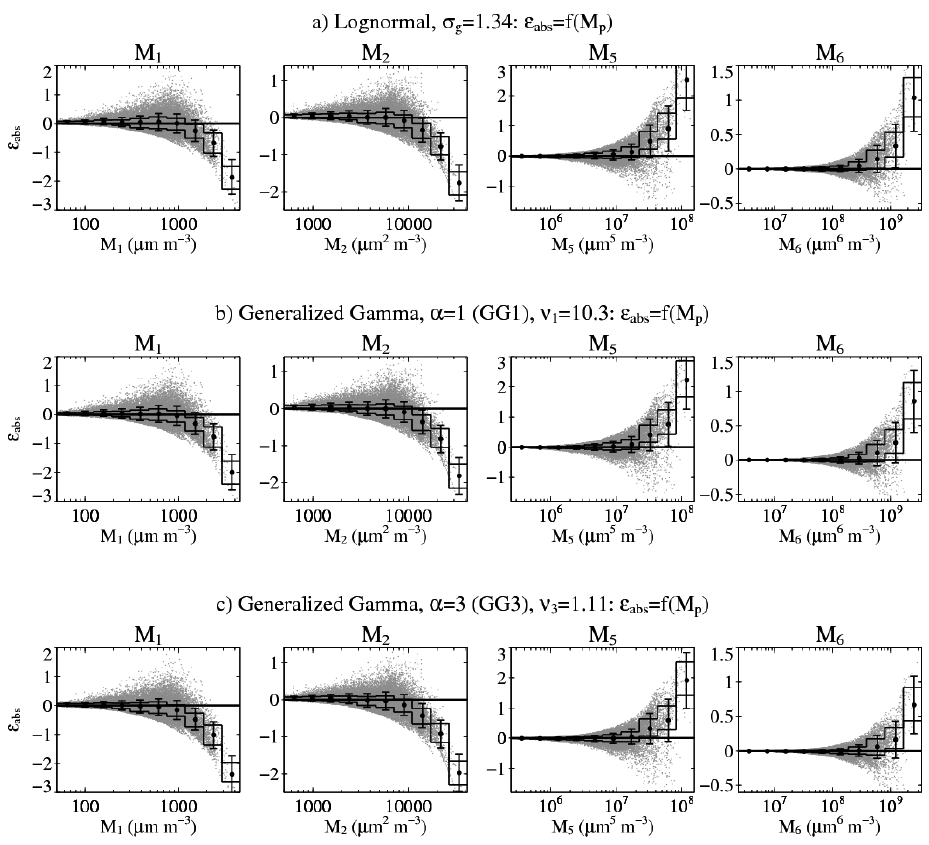
Fig. 3. Scatter-plots (grey points) of the absolute errors between the observed spectrum moment value and the one of the parametric function using the trade-off value of the tuning parameter σ ∗ g =1.34 for the Lognormal function (top row), ν ∗ =10.3 for GG1 (2nd row), and ν ∗ =1.11 for GG3 (3rd row), as a function of the moment values. The X-axis is divided in 10 classes as in Fig. 2. The thin lines denote the 25th and the 75th percentiles of the absolute error distribution in each class. The circles and the error bars denote the arithmetic mean and the arithmetic standard deviation of the absolute error values in each class. The absolute errors are normalized from left to right respectively by 100µmcm − 3 for M 1 , 1000µm 2 cm − 3 for M 2 , 10 7 µm 5 cm − 3 for M 5 and 10 9 µm 6 cm − 3 for M 6 .